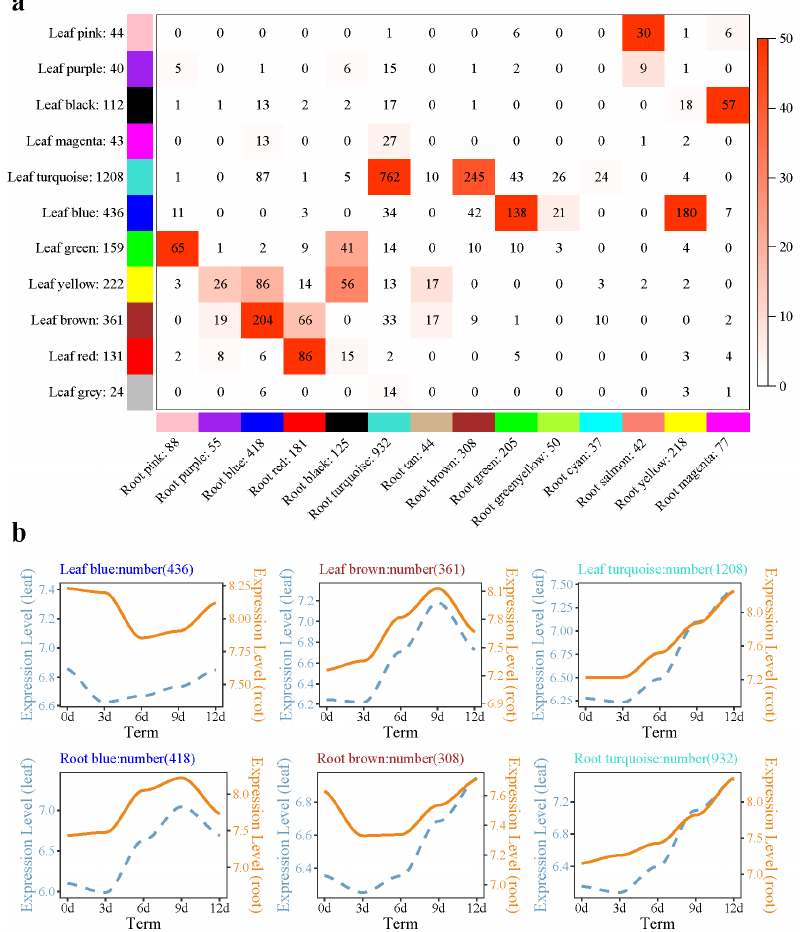
Figure 5. Root and needle coexpression network analysis of the P. massoniana drought process. ( a ) Overlap between needle set-specific and root set-specific modules in P. massoniana ; ( b ) different module gene expression patterns in needles and roots. Note: In subfigure ( a ), each row in the table corresponds to one needle set-specific module, and each column corresponds to one root set-specific module. The number in the labeled heatmap indicates the genes counted in the intersection between two parts of P. massoniana . Coloring of the table indicates significant overlap, evaluated using Fisher’s exact test. In subfigure ( b ), the left side of the double-axis represents the needles, the right side represents the roots, the text includes the number of modules and module names, and the gene trends in the module are processed by taking the logarithm of the gene expression in the module, fitted in a linear